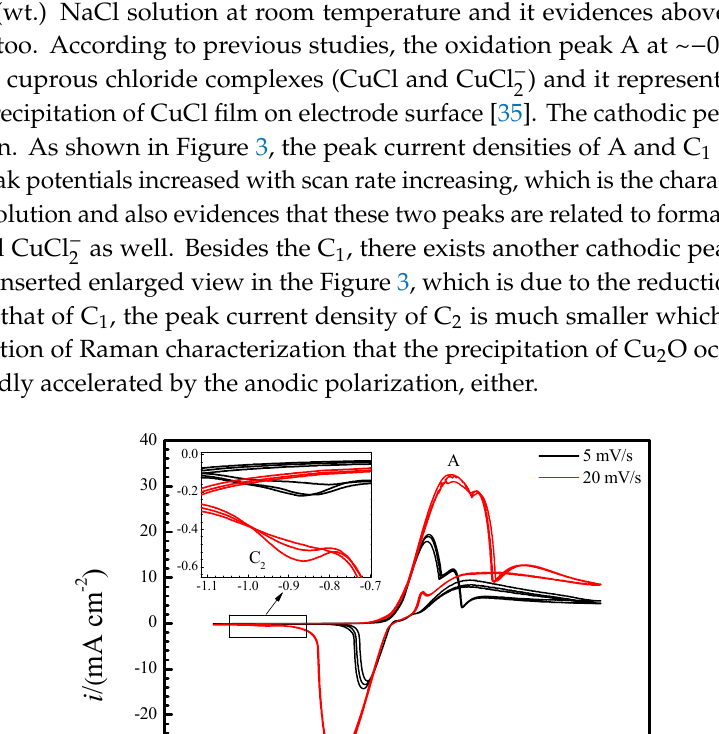
Figure 3. Stationary cyclic voltammograms after at least three cycles of copper electrode in neutral 3.5% (wt.) NaCl solution at room temperature.